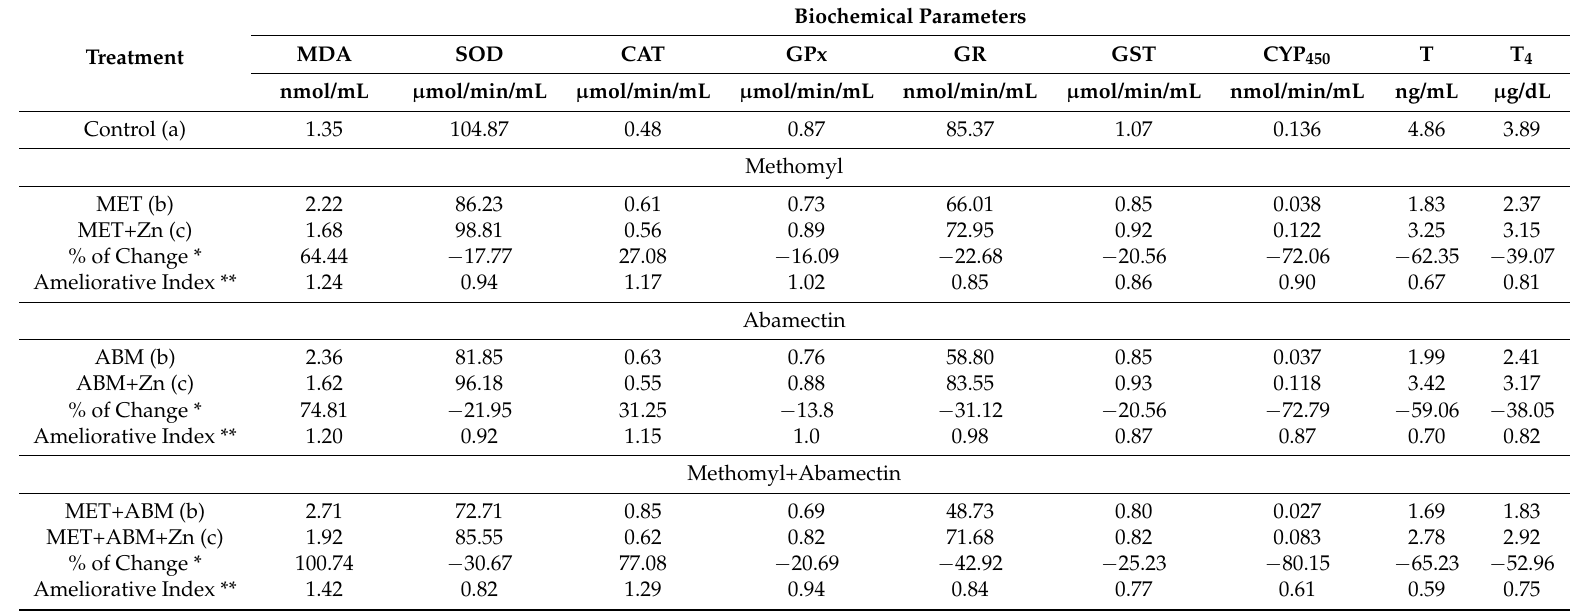
Table 2. The percent of change in some biochemical parameters, related to oxidative stress and hormonal disturbance, in male rats induced by methomyl (MET), abamectin (ABM), andthe mixture (MET+ABM), and the ameliorative effect of zinc supplementation. Biochemical Treatment